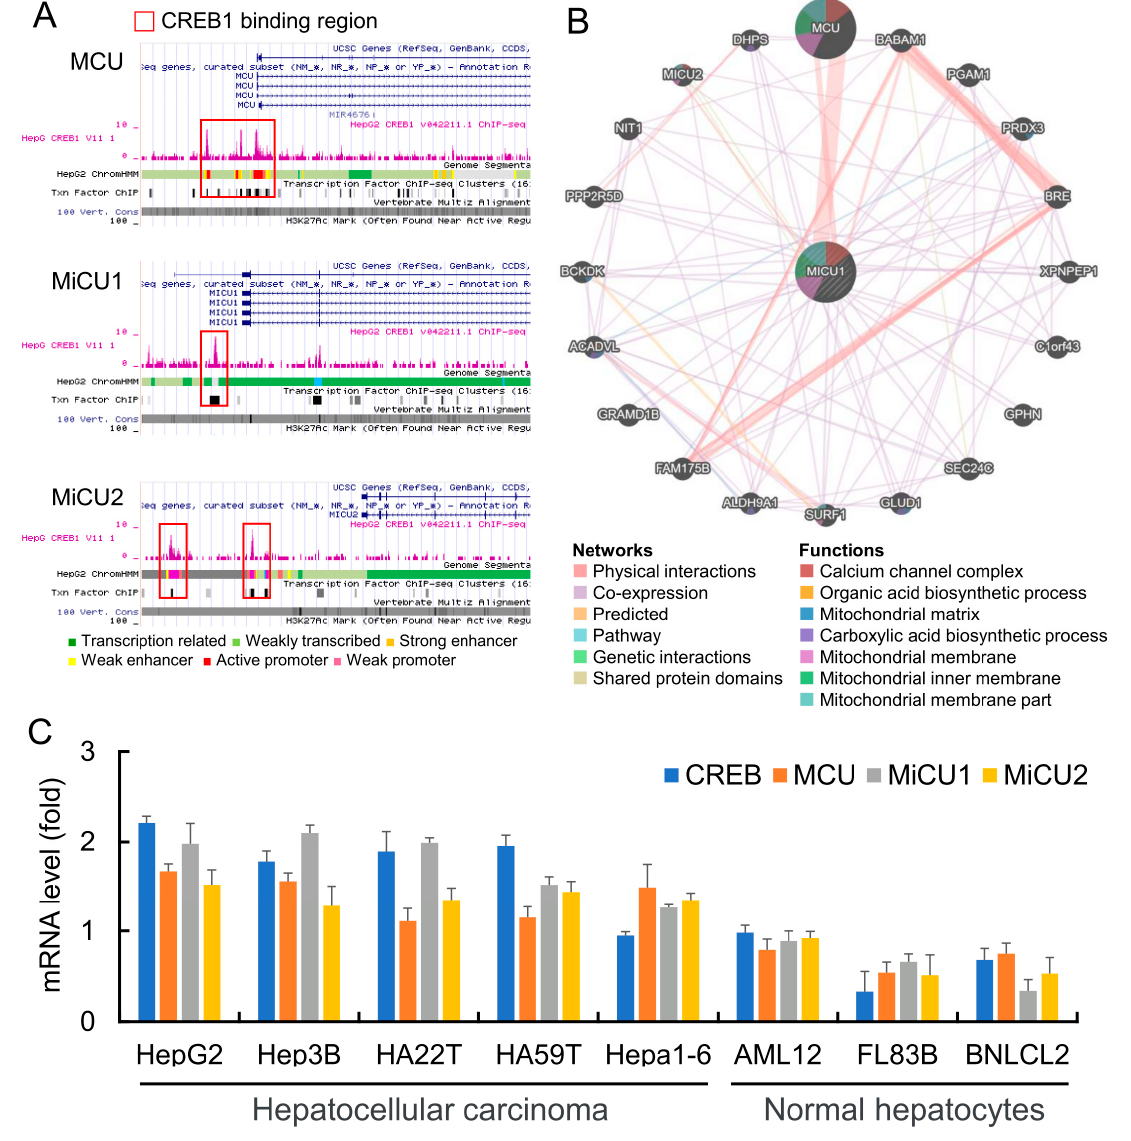
Figure 2. CREB was highly expressed and closely correlated with MCU, MICU1, and MICU2 in HCC. ( A ) Scheme of the human genomic region encompassing the MCU, MICU1, and MICU2 promoter. The pink peaks represent the CREB-binding regions, according to ENCODE. The red square shows the stronger binding region of each promoter. ( B ) Functional enrichment and signal pathway analysis